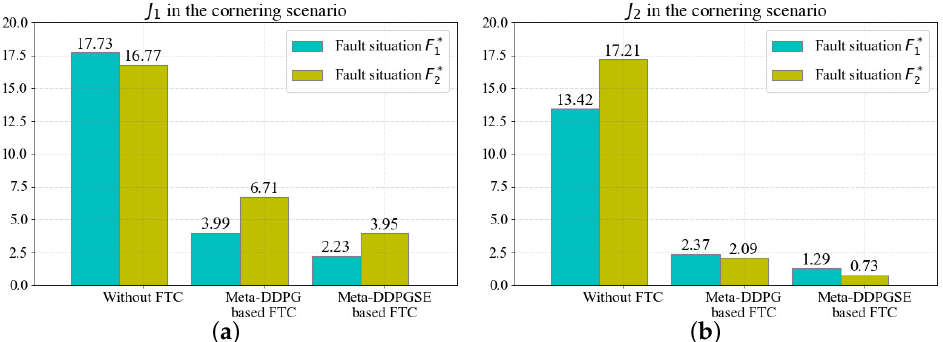
Figure 13. The quantitative evaluation in the cornering scenario: ( a ) J 1 in the cornering scenario; ( b ) J 2 in the cornering